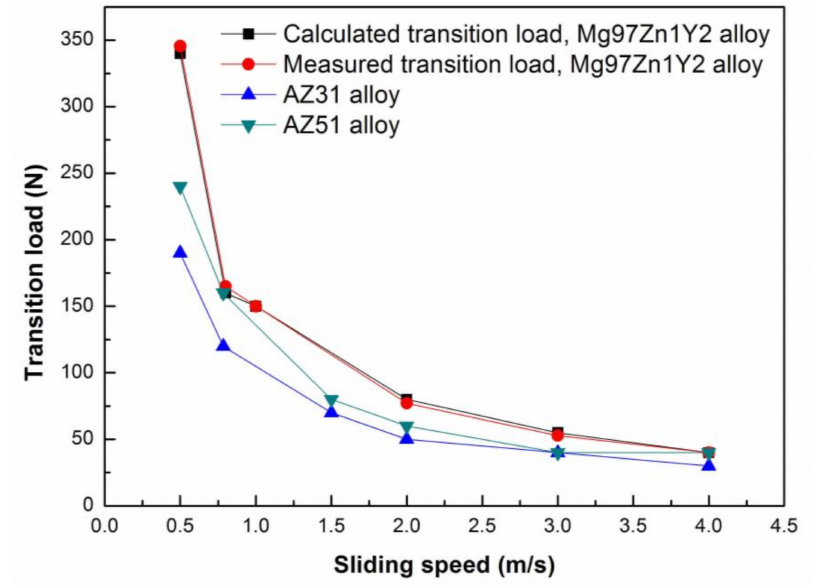
Figure 14. Measured and calculated transition loads of Mg97Zn1Y2 alloy at different sliding